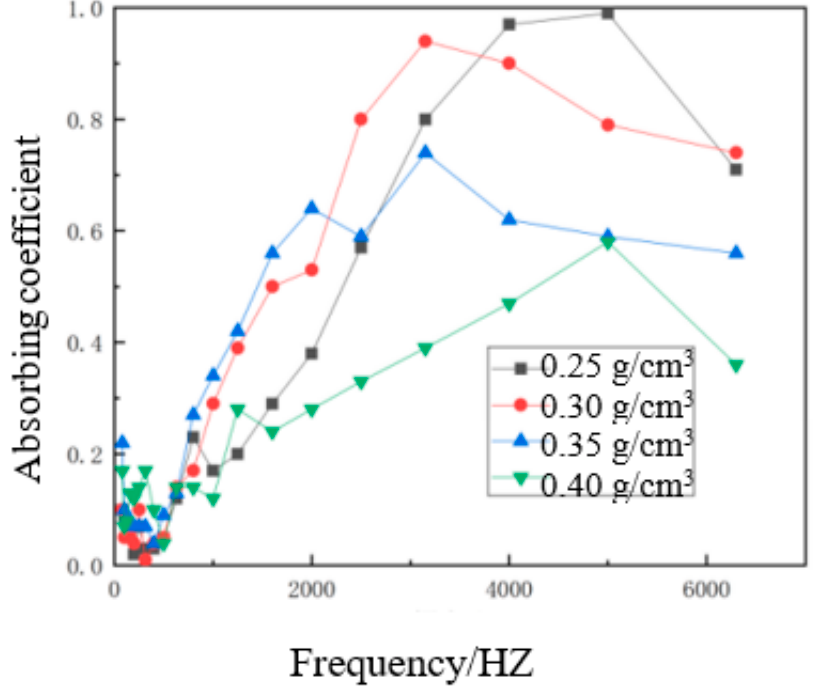
Figure 11. Curves of sound absorption coefficients for composite materials of different densities.